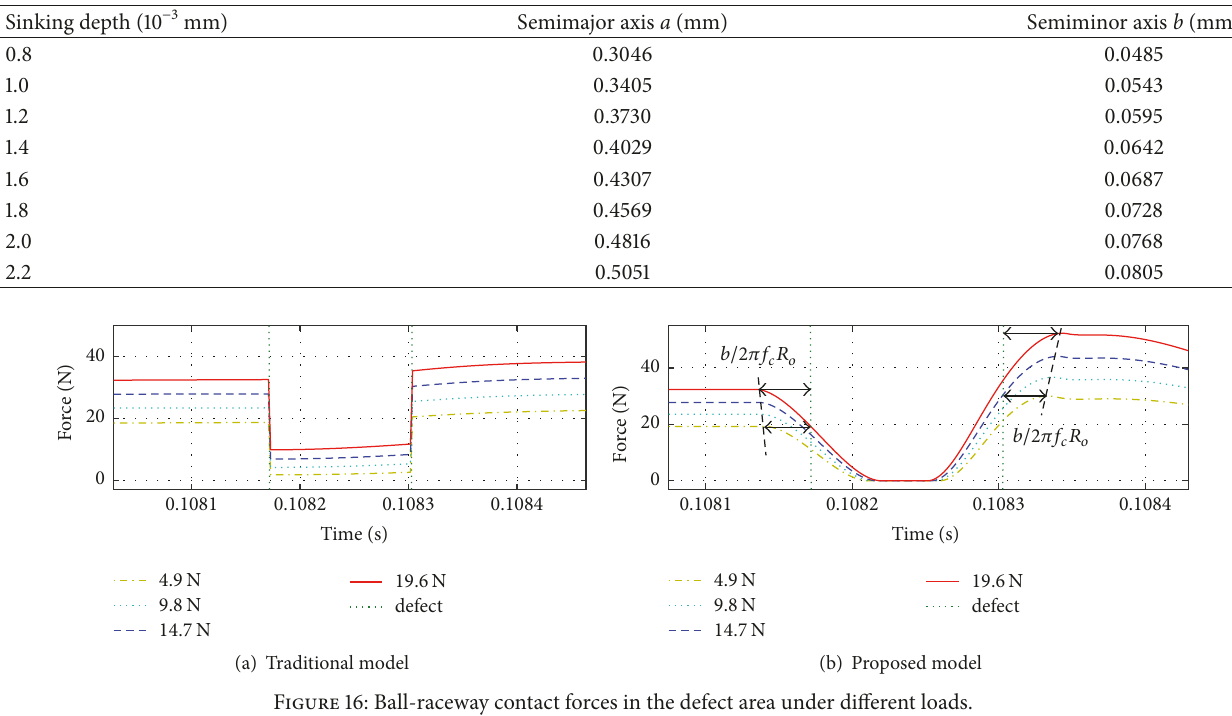
Figure 16: Ball-raceway contact forces in the defect area under different